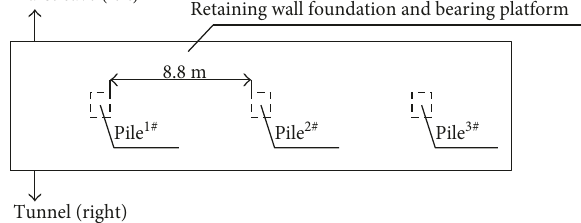
Figure 4: Position of the pile foundation.